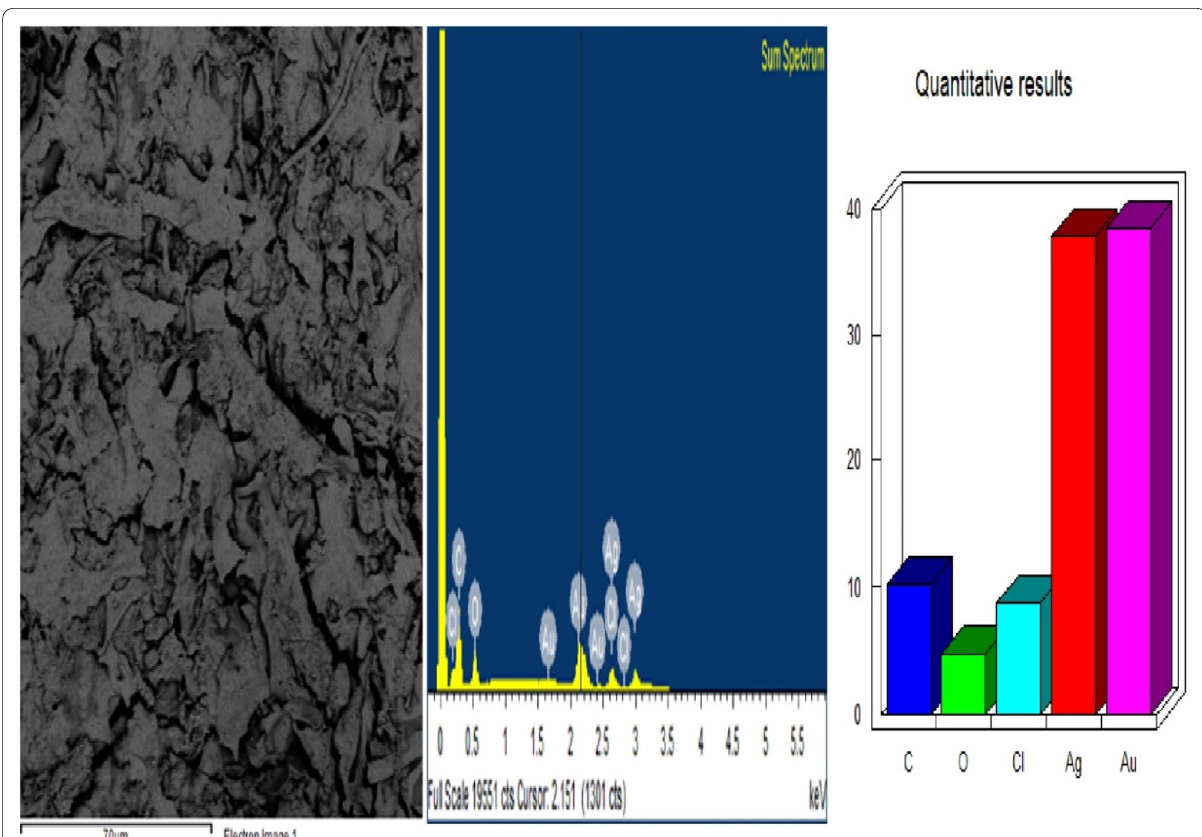
Fig. 6 EDX of the SNP synthesized by Leea coccinea leaf